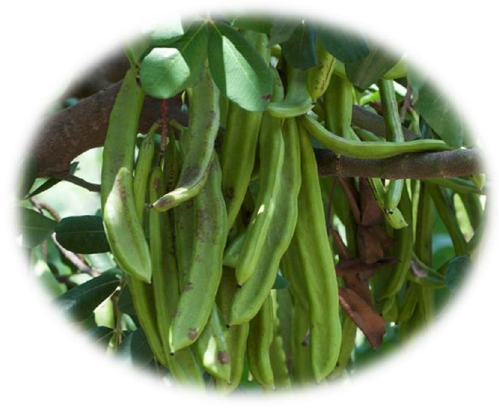
Fig. 7 Seeds gums of Ceratonia siliqua as a coagulant